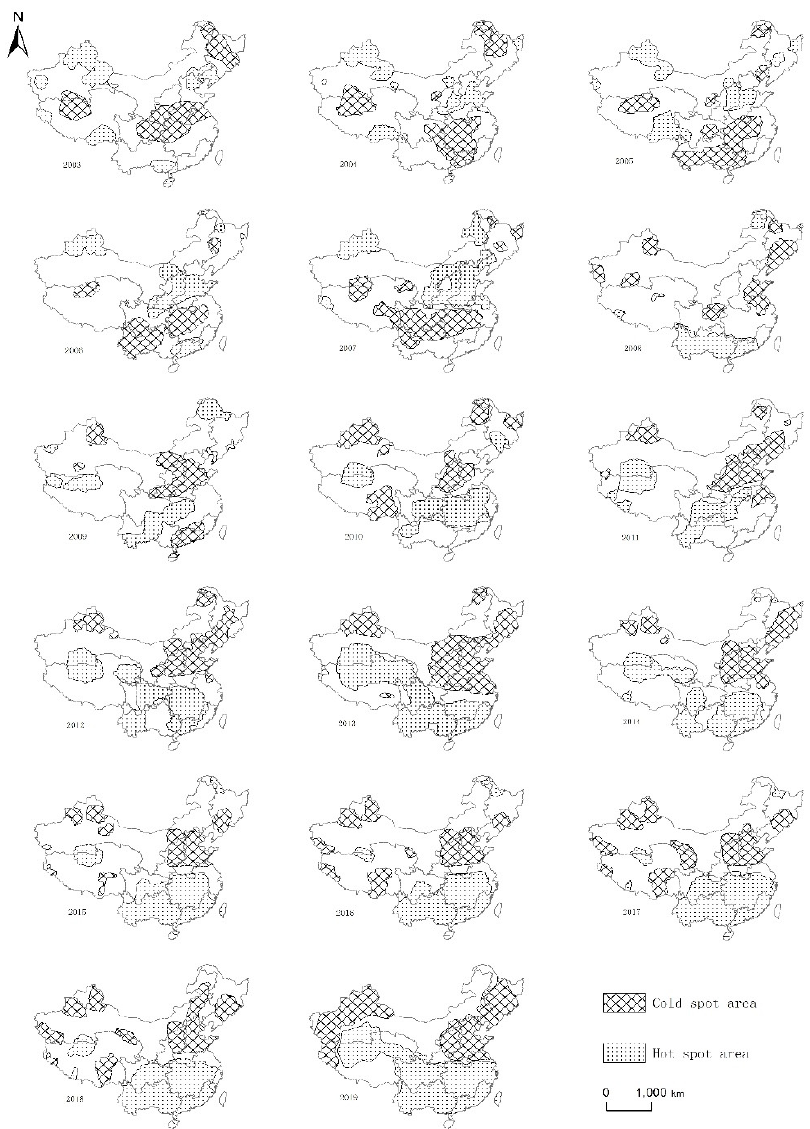
Figure 2. Spatial distribution of aggregation characteristics of groundwater storage change during 2003–2019 based on the Getis-Ord Gi* method. The hot spots and cold spots of groundwater storage change in China are analyzed by converting the monthly groundwater storage change data obtained by GRACE to an annual scale. Above all, the annual groundwater storage changes were analyzed by spatial autocorrelation, and we found that the annual groundwater storage changes had significant, positive spatial correlation. Then, we used the Getis-Ord Gi* method to analyze the spatial distribution of aggregation of groundwater storage changes. By visualizing hot spots and cold spots with confidence levels of 90%, pixels that had not passed the significance test were directly ignored. The cold spots and hot spots regions illustrate groundwater storage change aggregated with a negative trend and increased trend,